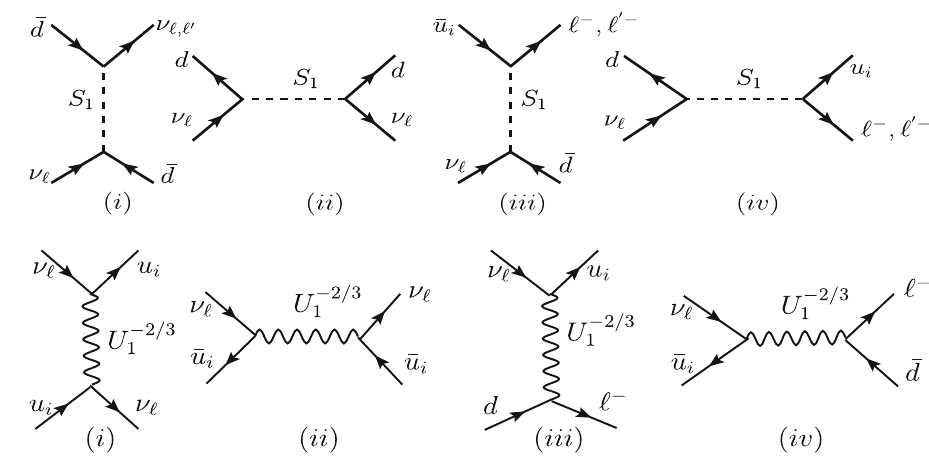
Fig. 4 The relevant Feynman diagrams for the neutrino-quark interactions mediated by the vector LQ U